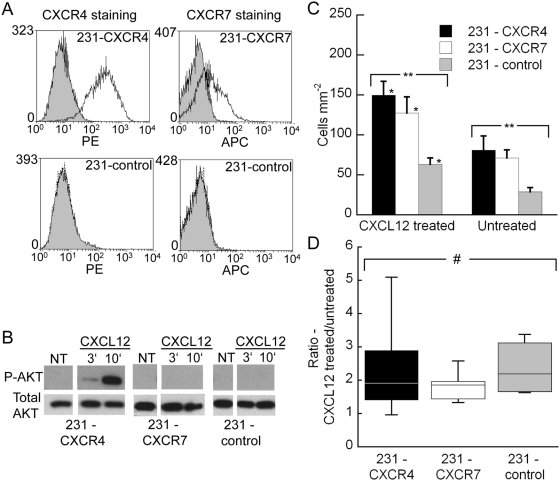
Endothelial cells mediate CXCL12-dependent enhancement in adhesion of cancer cells.(A) Flow cytometry with antibodies to CXCR4 (12G5) or CXCR7 (11G8) shows expression in stably transduced cell lines and absence of these receptors in 231-control cells. Filled histogram, isotype antibody control; open histogram, antibody stain. Isotype control staining overlapped with unstained cells (not shown on the plots). (B) CXCL12-dependent activation of AKT in 231 cells determined by Western Blot. Breast cancer cell lines were cultured overnight in medium containing 0.5% serum and then treated with 100 ng ml−1 CXCL12 for 3 min, 10 min, or no CXCL12 (NT). Cell lysates were probed for phosphorylation of AKT at serine 473. Blots then were stripped and probed for total AKT as a loading control. Similar results were obtained with 300 ng ml−1 and incubations extending through 30 minutes. (C) Adhesion of 231-CXCR4, 231-CXCR7, and 231-control cancer cells onto CXCL12 treated versus untreated endothelium under 0.50 dyn cm−2 shear flow conditions. For all three cancer cell-types, adhesion selectivity was towards the CXCL12 treated region of the endothelium over the corresponding untreated region (*). The level of adhesion of the three different cancer cell-types was statistically different on both the CXCL12 treated and untreated endothelial regions (**). Data are expressed as mean+s.e.m. (D) Adhesion selectivity of cancer cells towards the CXCL12 treated endothelial region over the untreated region under 0.50 dyn cm−2 flow conditions. Adhesion selectivity to CXCL12-stimulated endothelium was comparable for all cancer cell lines, regardless of expression of CXCR4 or CXCR7. #, p = 0.48. Statistical significance as determined by Mann-Whitney (*, p<0.05) for pair wise comparison and Kruskal-Wallis (**, p<0.05) for comparison of more than two groups.